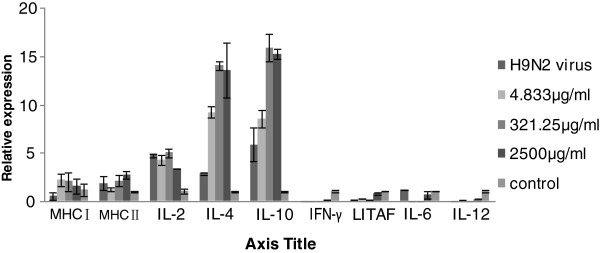
Illustrates real-time quantitative PCR analysis of major histocompatibility complexes (MHC) I, MHC II, and cytokines IL-2, IL-4, IL-10, IFN-γ, LITAF, IL-6, and IL-12 in Astragalus polysaccharide-treated chick embryo fibroblasts (CEF) infected with H9N2 AIV. IL-4 and IL-10 were expressed to high levels for CEF treated with 321.25μg/mL APS.